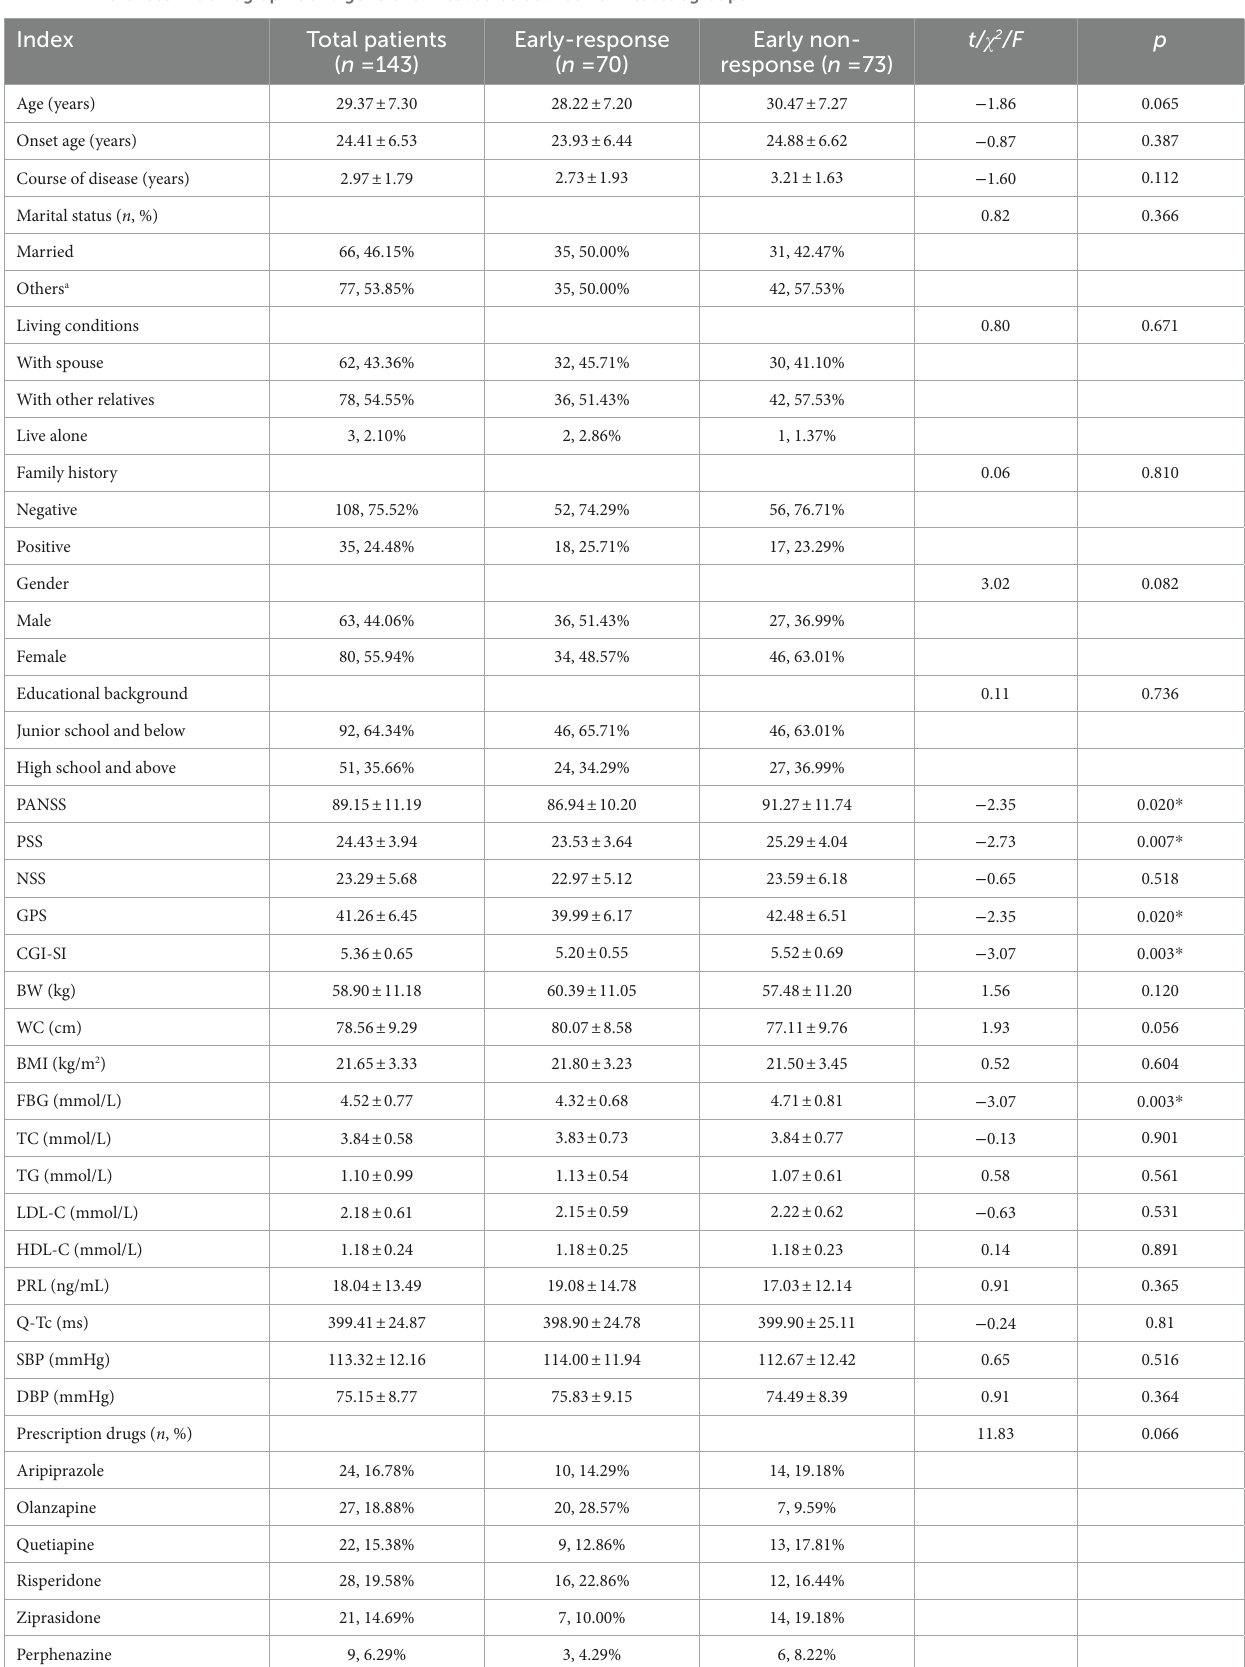
TABLE 1 Differences in demographic and general clinical datas between clinical